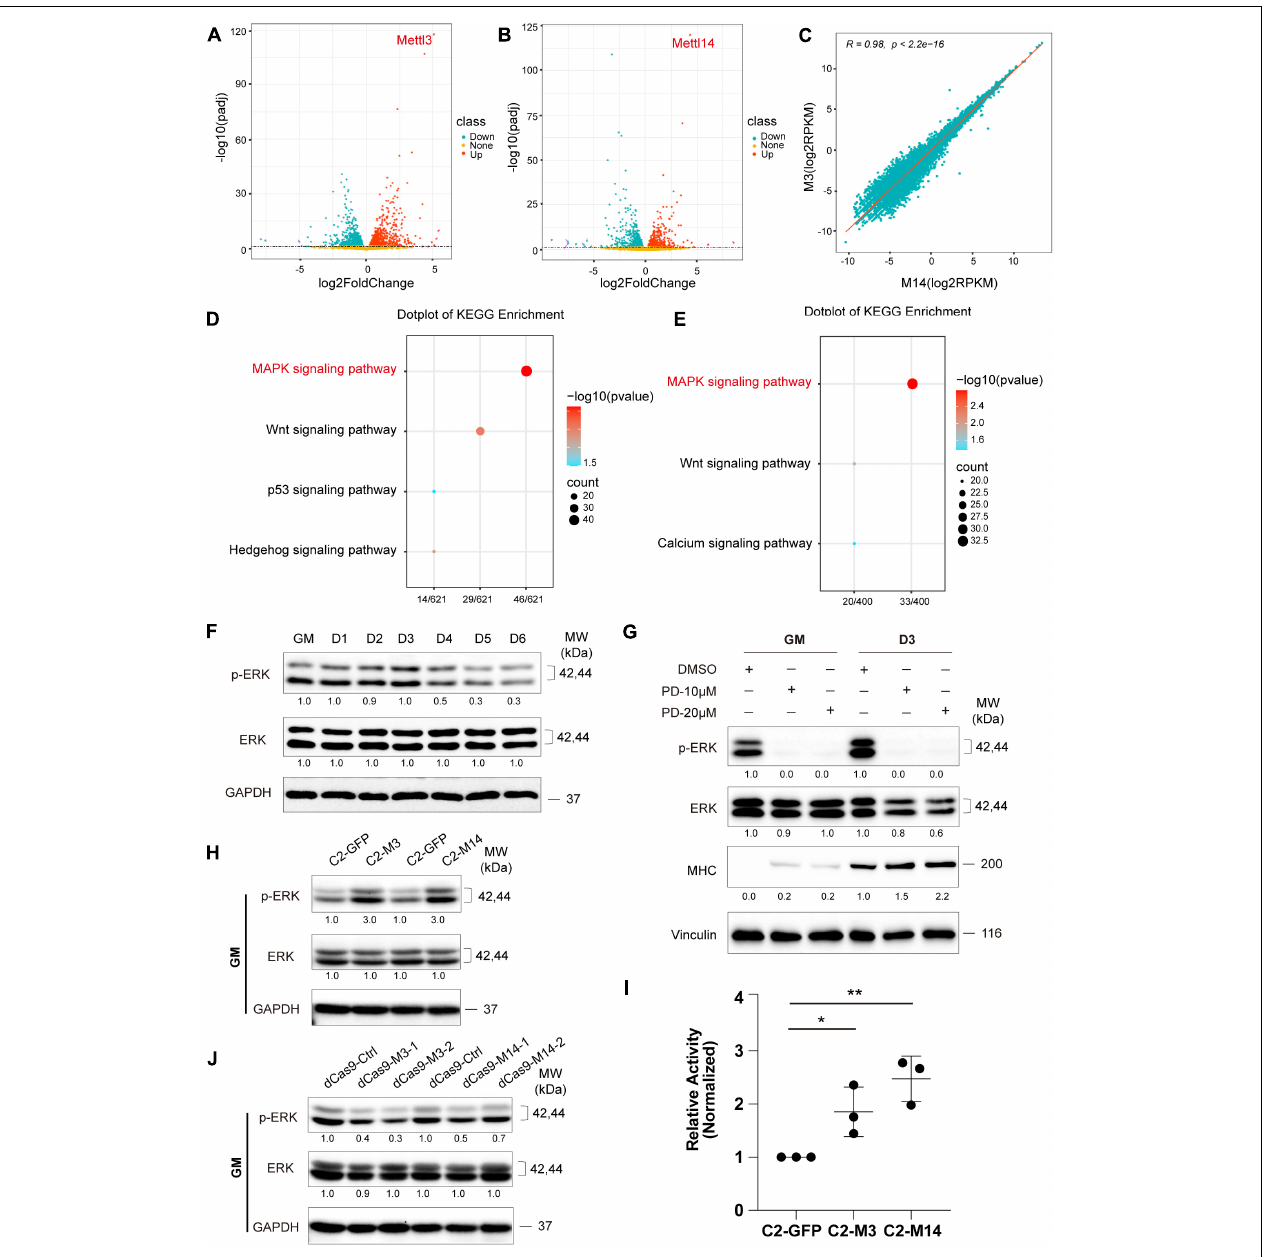
FIGURE 3 | METTL3/14 activates ERK signaling in C2C12 cells. Volcano plot of differentially expressed genes in METTL3- (A) or METTL14- (B) overexpressing C2C12 cells in GM condition. (C) Correlation analysis of RNA profiles of METTL3- and METTL14- overexpressing C2C12 cells in GM condition. KEGG enrichment analysis of METTL3- (D) or METTL14- (E) overexpressing C2C12 cells. (F) Western blot analysis of ERK and its phosphorylated forms p-ERK of differentiation C2C12 myoblasts. (G) Western blot analysis of ERK, p-ERK and myogenic marker MHC in C2C12 cells that were treated with different dose of PD0325901 (PD) or DMSO for 48 h in growth medium (GM) or for 48 h in growth medium then shifted to differentiation medium for 3 days (D3). DMSO as negative control. (H) Western blot analysis of ERK and p-ERK in METTL3- or METTL14- knockdown C2C12 cells in GM condition. (I) The pathway assay revealed METTL3/14 affected the activity of ERK signaling. This examination was carried out in GM condition and the results were normalized to GFP overexpressing cells. Quantitative data was represented as Mean ± SD. The statistical significance of difference between two means was calculated with the t -test, * p < 0.05, ** p < 0.01. (J) Western blot analysis of ERK and p-ERK in METTL3 or METTL14 knockdown C2C12 stable cell